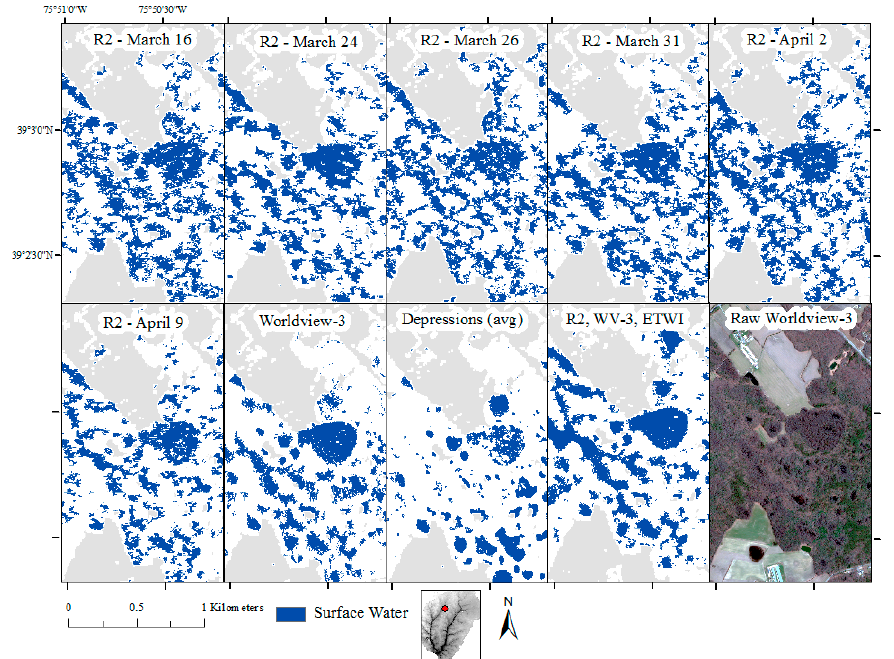
Figure 6. An example of variation in forested surface water extent (non-forested areas are masked out on map products) as mapped with the six Radarsat-2 (R2) dates, Worldview-3 (WV3) imagery, depressions derived from the average wetness condition lidar, and the combined model. The depression filter has been applied to the surface water maps. Radarsat-2 shows relatively poor outputs, with poorest quality for dates with recent precipitation. The combined model shows the most coherent map of surface water extent. ETWI: enhanced topographic wetness index. Copyright 2017 Digital Globe, Next View License.